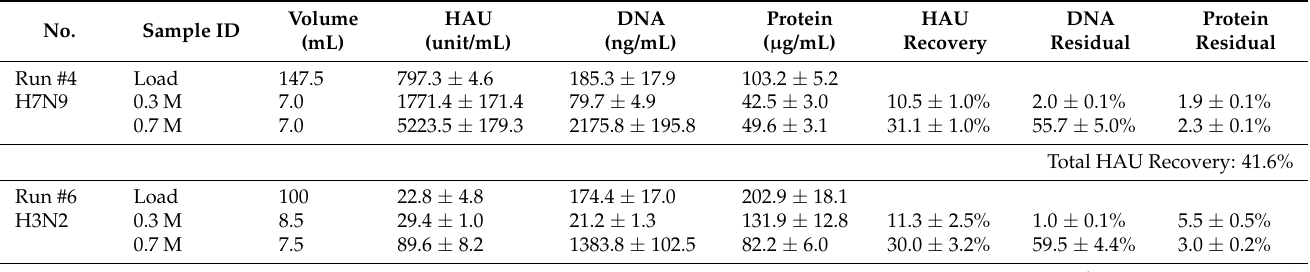
Table 6. Purification of pandemic strains H7N9 and H3N2 with Mustang ®